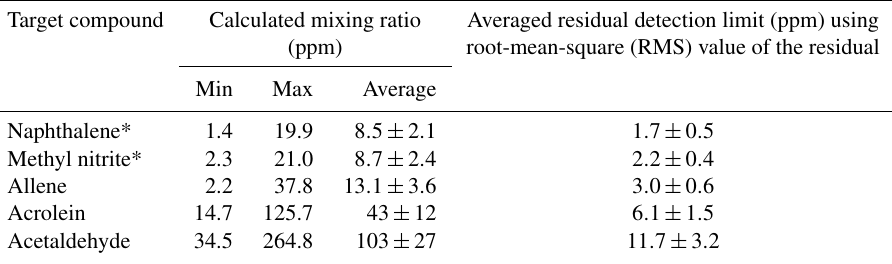
Table 3. Calculated mixing ratios for 10 canister FTIR measurements along with average estimated residual detection limits for the target compounds derived using 3 times the root mean square of the residual in very congested spectra. Error bars represent standard error of the mean.